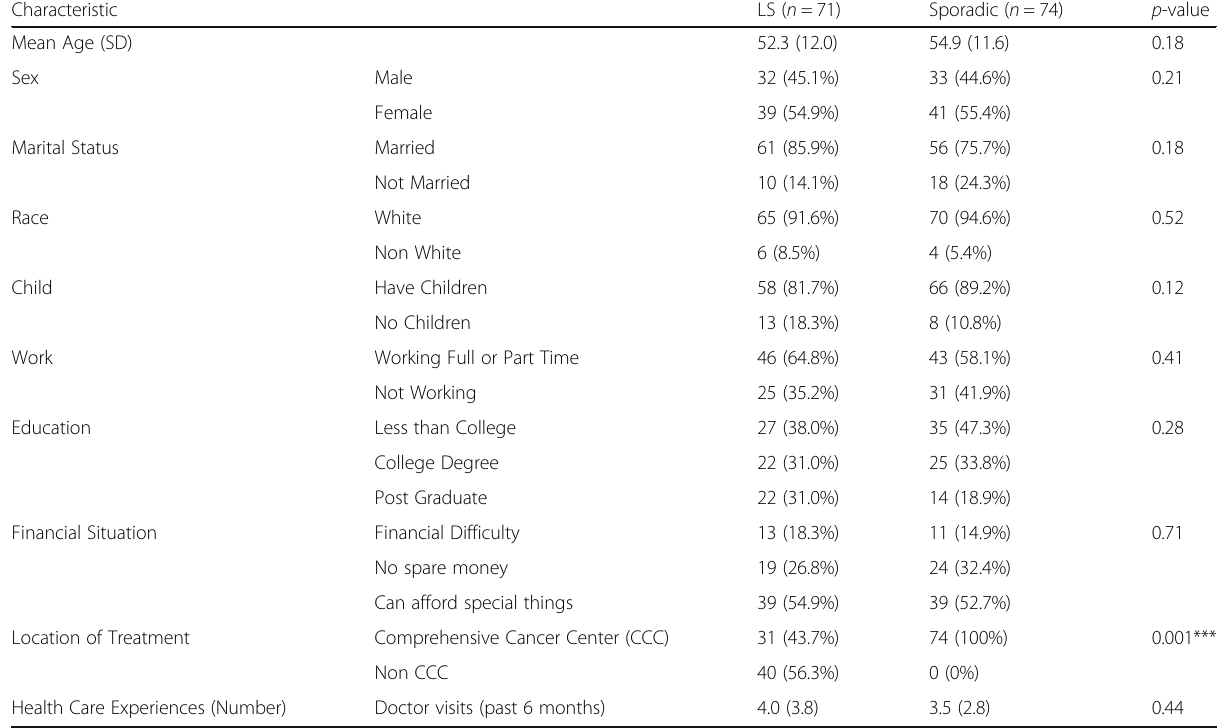
Table 1 Demographic characteristics of Lynch syndrome (LS) and sporadic participants [n (%)] Characteristic